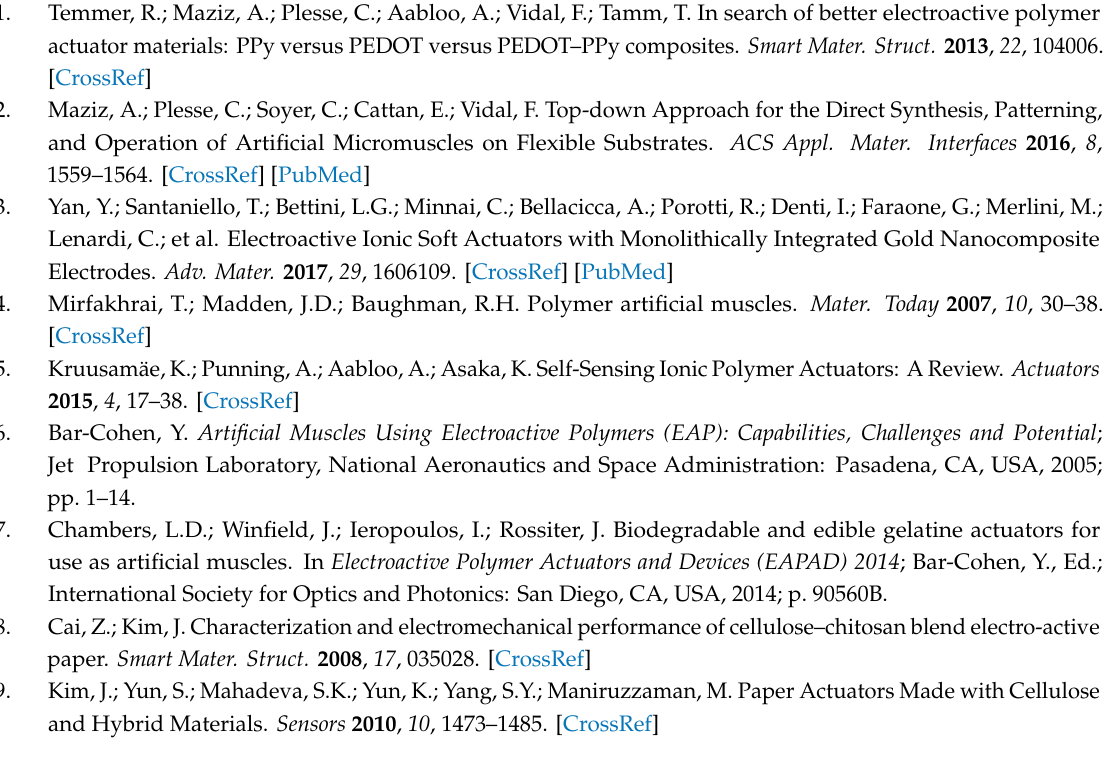
Figure S1: The unit cell, which contains 400 [Ch][Ac] ion pairs and 207 water molecules (to reproduce the mass content of water—5.4%). Isometric periodic boundary conditions were applied, Figure S2: Five cations and three anions of [Ch][Ac] and two water molecules cut from the Molecular Dynamics trajectory. The H-bonds between choline cations are depicted as green, Figure S3: A fusion of partially dried fibers in the gelatin membrane, Figure S4: An example of a frequency response graph of PPy-gelatin-[Ch][Ib] actuator, Figure S5: An example of a frequency response graph of PPy-gelatin-[Ch][Mal]